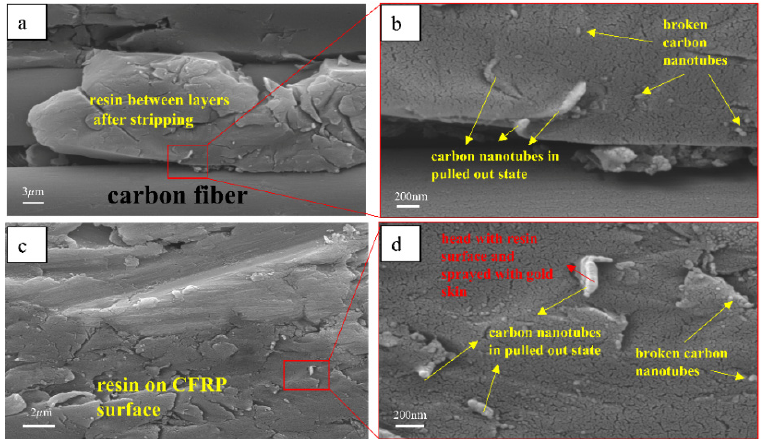
Figure 11. Metallographic diagram of shear failure of laminate C. ( a ) the electron microscope picture of the surface of the CFRP layer after shear failure of laminate C. ( b ) an enlarged view of ( a ). ( c ) the electron microscope picture of the surface of the CFRP layer after shear failure of laminate D. ( d ) an enlarged view of ( c ).